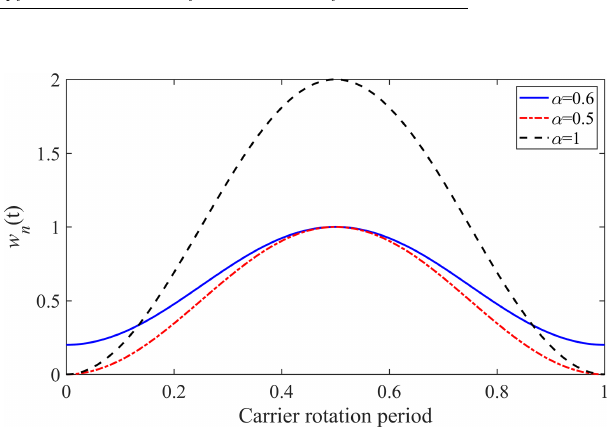
Figure 6. The effect of coefficient α on the transfer path